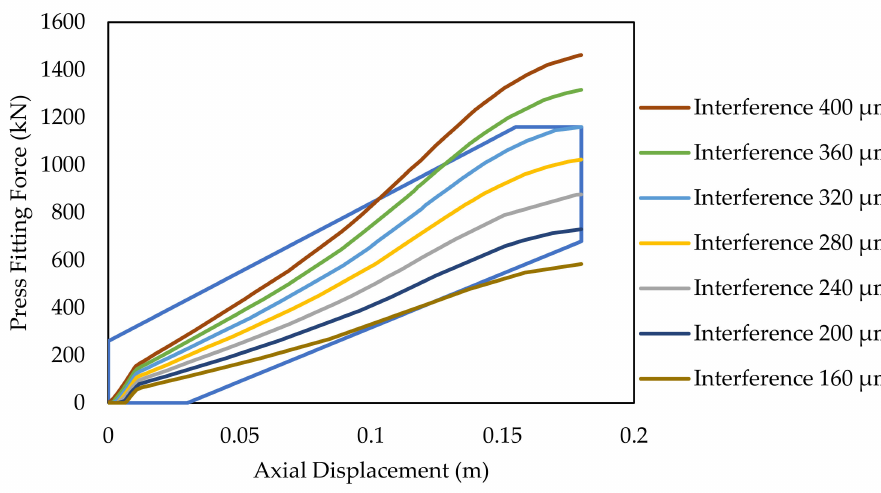
Figure 10. Press-fitting curves vs interference derived from the finite element